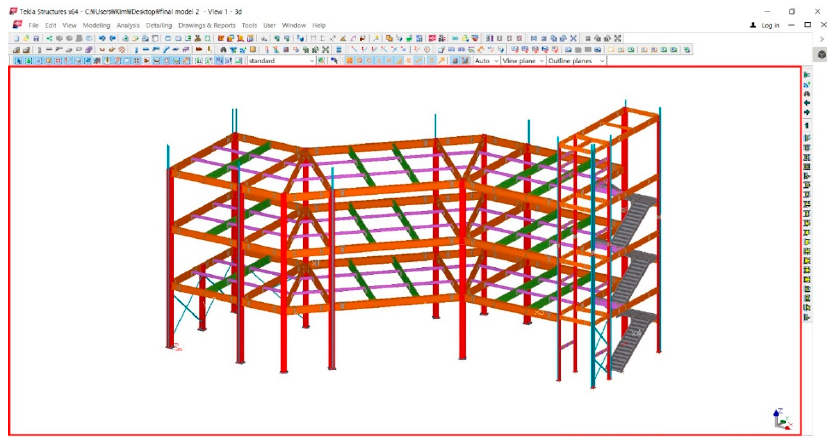
Figure 3. BIM model of a prefabricated steel frame.